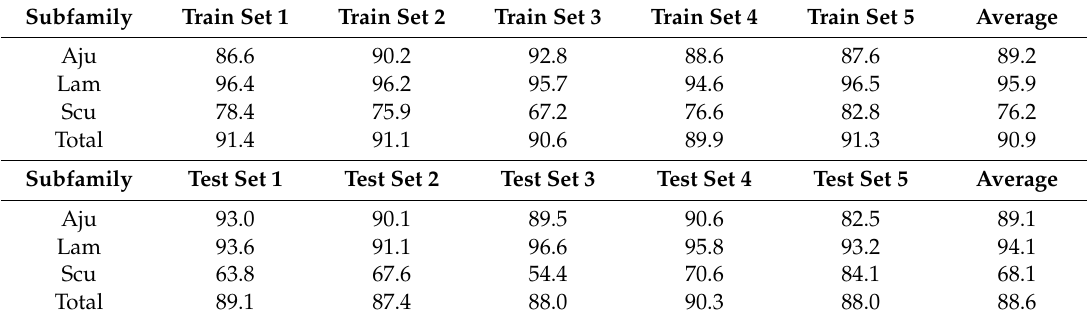
Table 6. Summary of the results of training and test match (%) of Aju, Lam and Scu. Subfamily